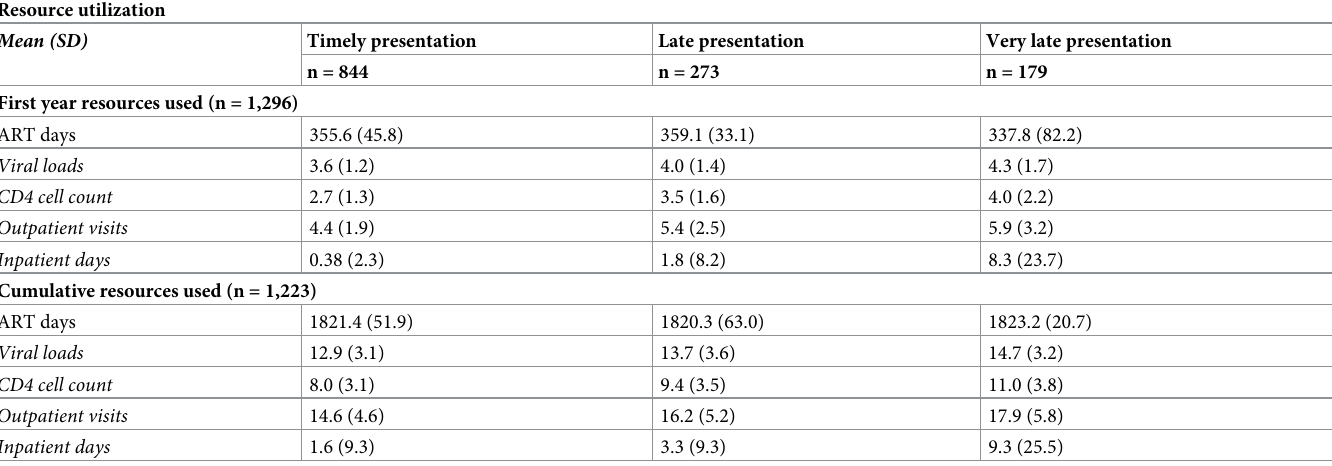
Table 2. Resource utilization during the first and cumulative at five years on ART, based on moment of presentation in HIV-care. Resource utilization Mean